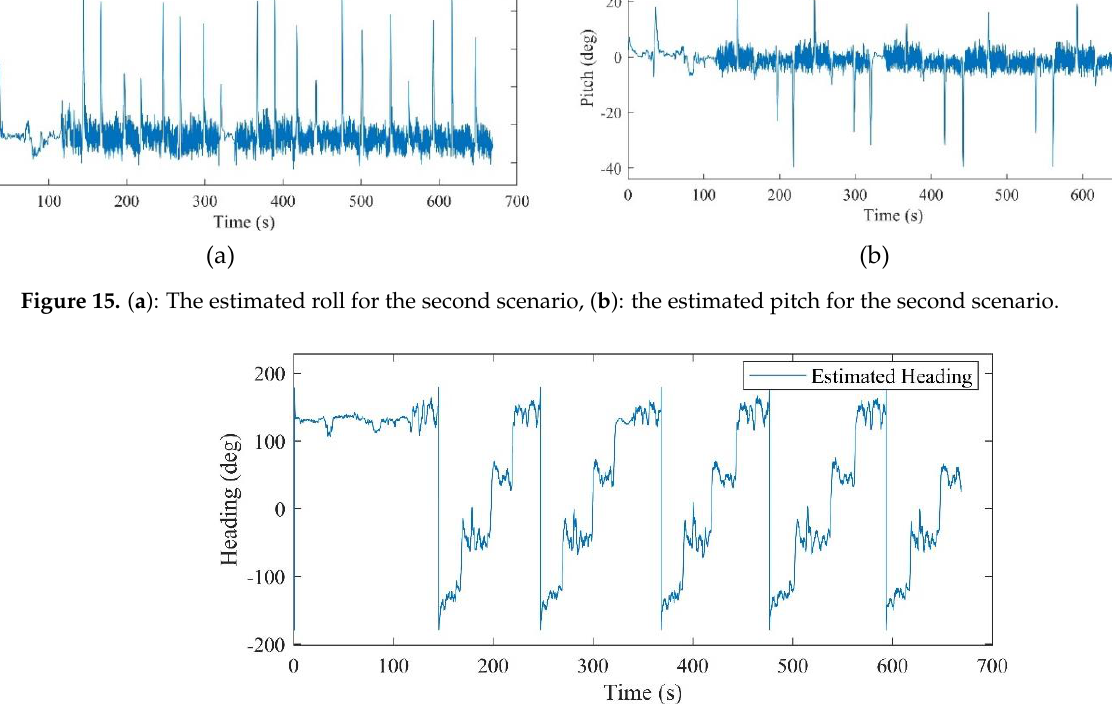
Figure 16. The estimated heading for the second scenario.